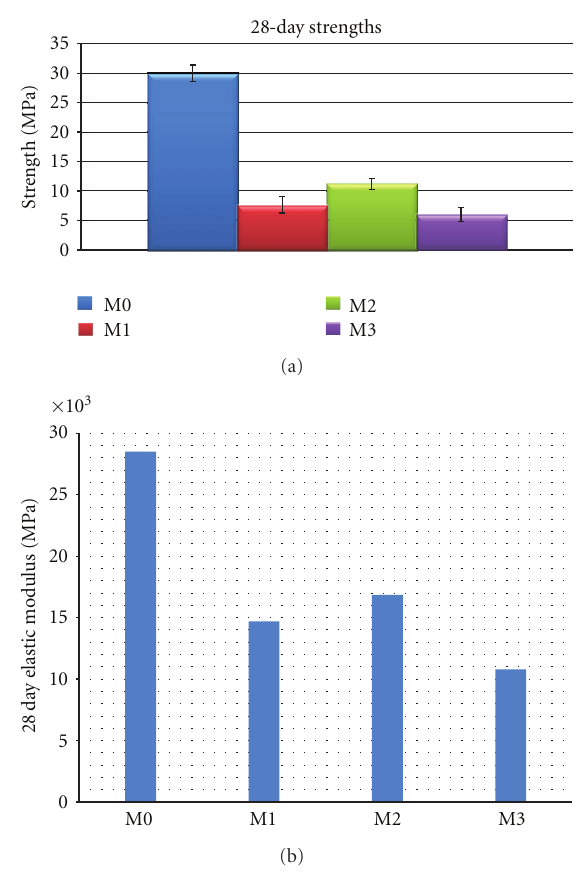
Figure 5: (a) 28-day compressive strengths, (b) 28-day elastic mod-